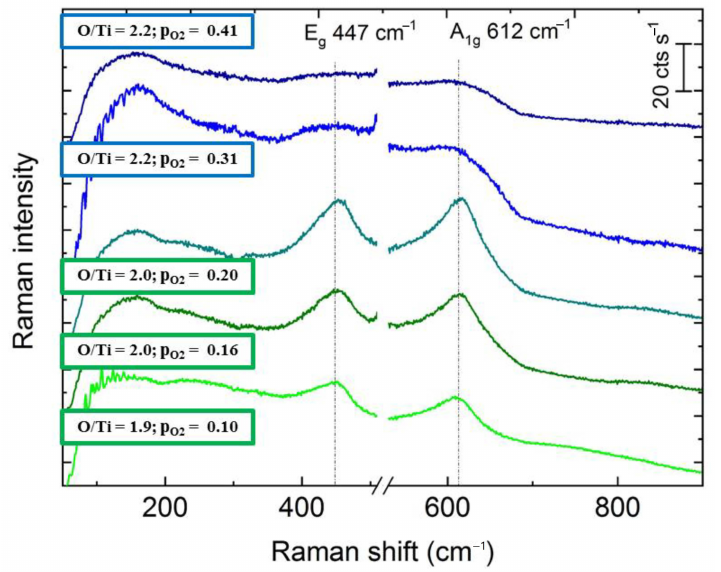
Figure 8. Raman spectra of samples in G2 and G3. Reference lines for the Eg and A 1g positions of rutile- type TiO 2 are included in the graph. Spectra were offset vertically for better visibility. The contribution of Si at 20 cm − 1 was removed from the